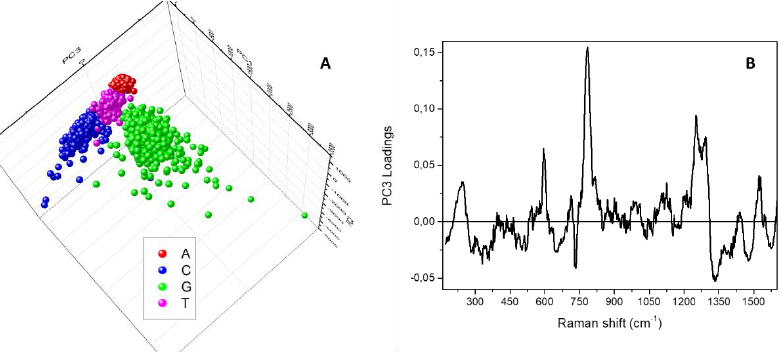
Figure 5. ( A ) Three-dimensional score plot resulting from the Principal Component Analysis per- formed on the spectra composing the Raman map acquired on adenine (red squares), cytosine (blue circles), guanine (green upward triangles) and thymine (magenta downward triangles) samples. ( B ) Spectral loadings corresponding to the third principal component,